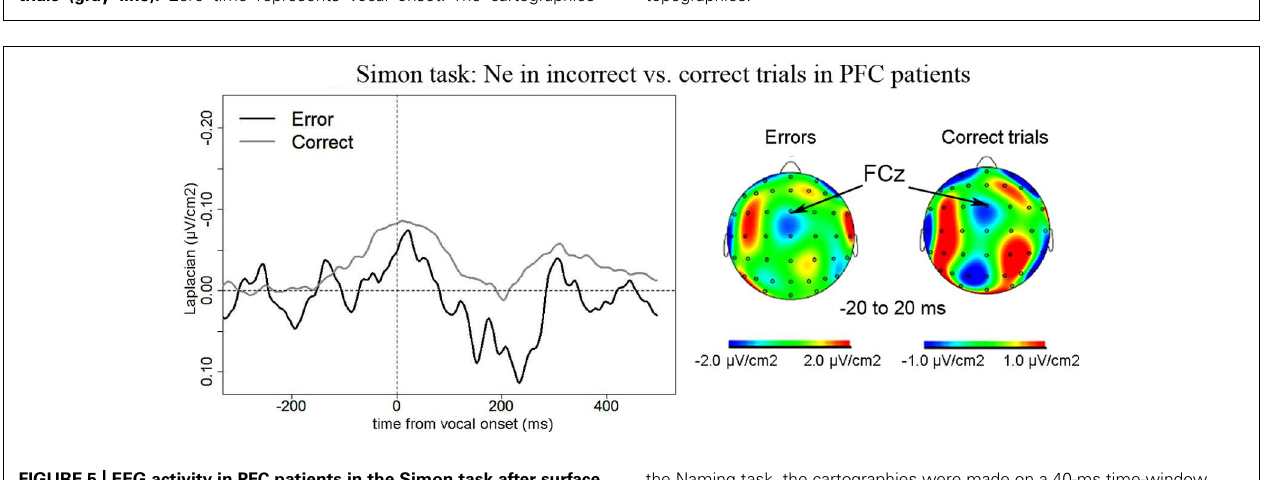
FIGURE 4 | EEG activity in PFC patients after surface Laplacian transformation in the Naming task, recorded at left (T7, TP7) and right (T8, TP8) temporal electrodes for error (black line) and correct trials (gray line). Zero time represents vocal onset. The cartographies